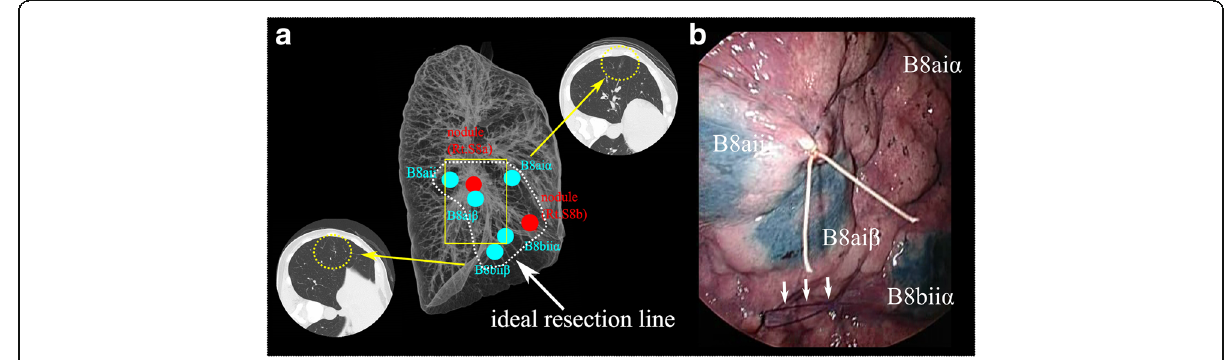
Fig. 2 a Three-dimensional configuration of the CT for “ mapping ” for the first operation. b A thoracoscopic view corresponding to the yellow square in a . The “ standing stitch ” with blue suture (white arrows) near a marking spot indicates the resection line between S8 and S9 and a silk stitch just above the nodule in right S8a. The geometric information of ideal resection line was obtained from marking spots and blue sutures were placed along the resection